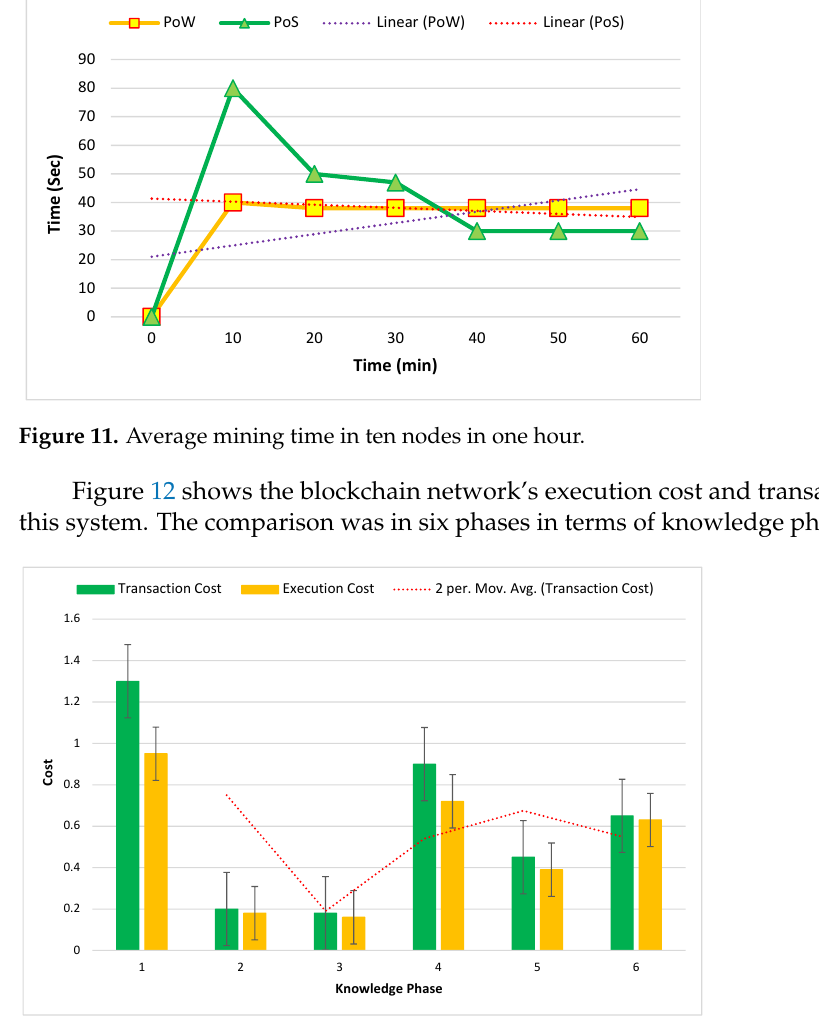
Figure 12. Knowledge phase of transactional and execution costs of the blockchain